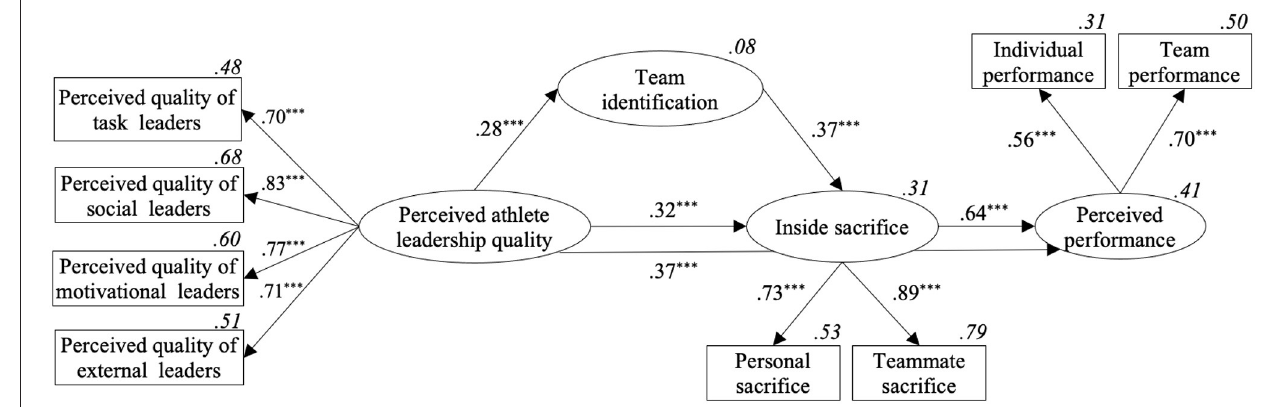
FIGURE 1 | SEM of the relationships between perceived athlete leadership quality, team identification, inside sacrifice and perceived performance. *** p < 0.001. Proportions of explained variance are presented in italics.